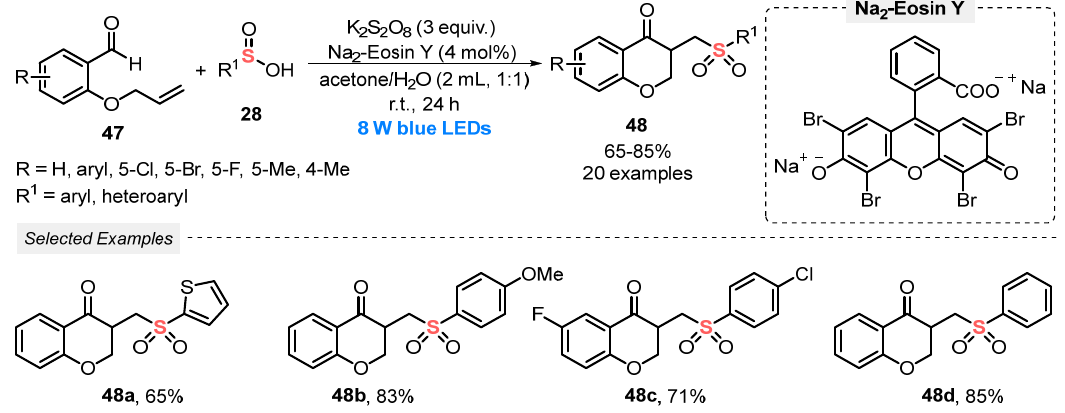
Scheme 22. Radical cascade cyclizations of 1,7 ‐ enynes 45 with sulfinic acids 28 promoted by visible